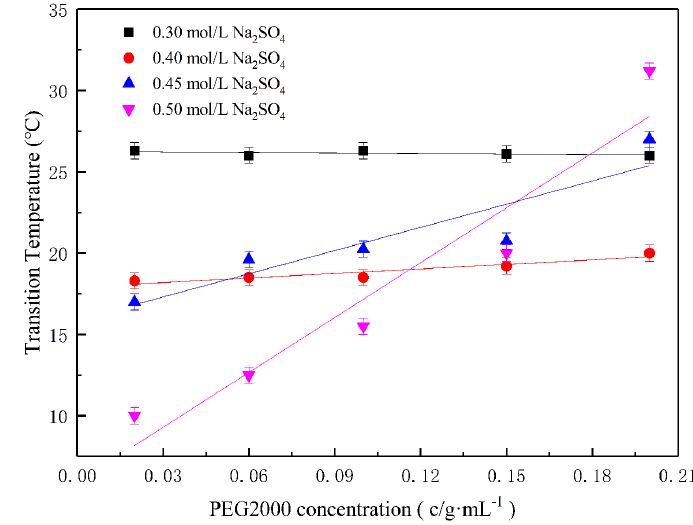
Figure 5. Effects of PEG2000/Na 2 SO 4 concentration on the phase transitions temperature of